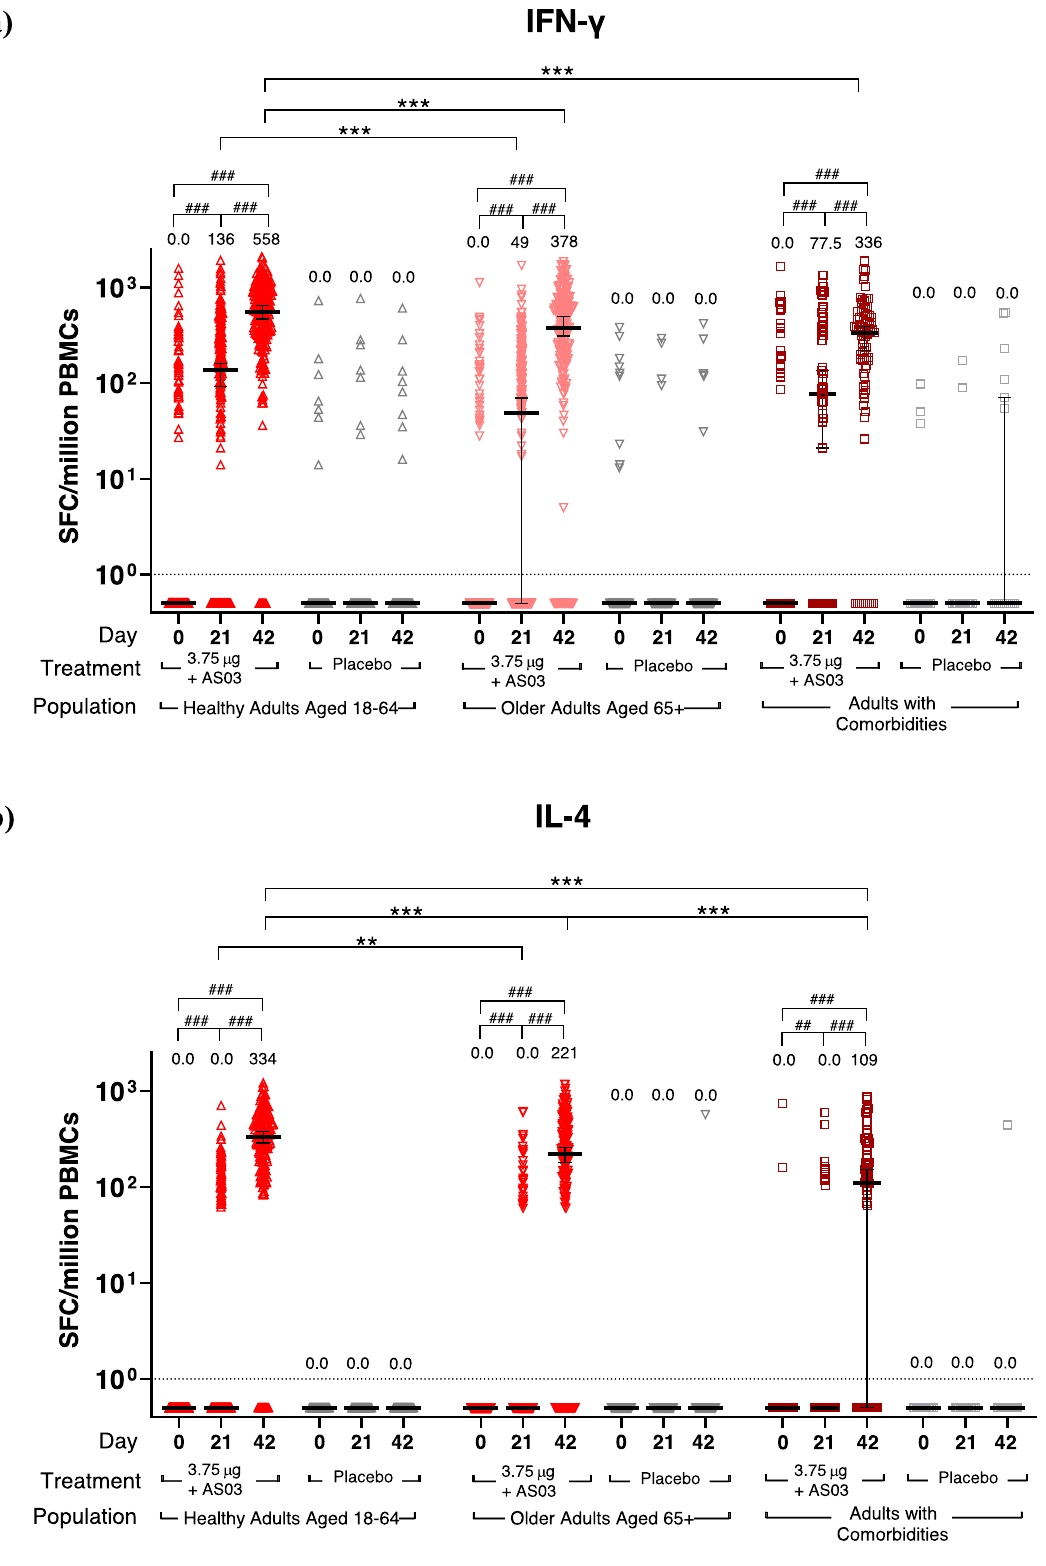
+ AS03 elicited an IL-4 response after one dose (33%, 17% and 18% in Healthy Adults, Older Adults and Adults with Comorbidities respectively), the proportion of responders increased to 92% (Healthy Adults), 79% (Older Adults) and 62% (Adults